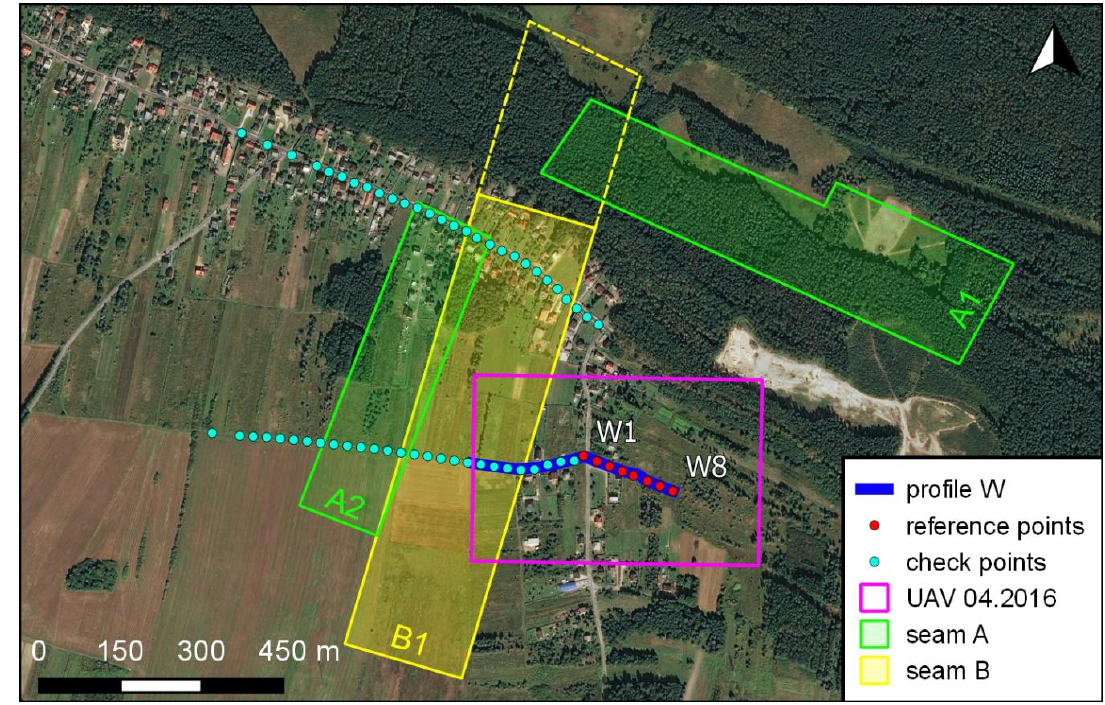
Figure 2. Jaworzno site: sketch of the observation network used for two measurement series against the background of a UAV-derived orthomosaic and locations of mining walls in the study area. 2.3. Determining and Estimating the Accuracies of Coordinates Obtained Using Unmanned Aerial Vehicles (UAVs)